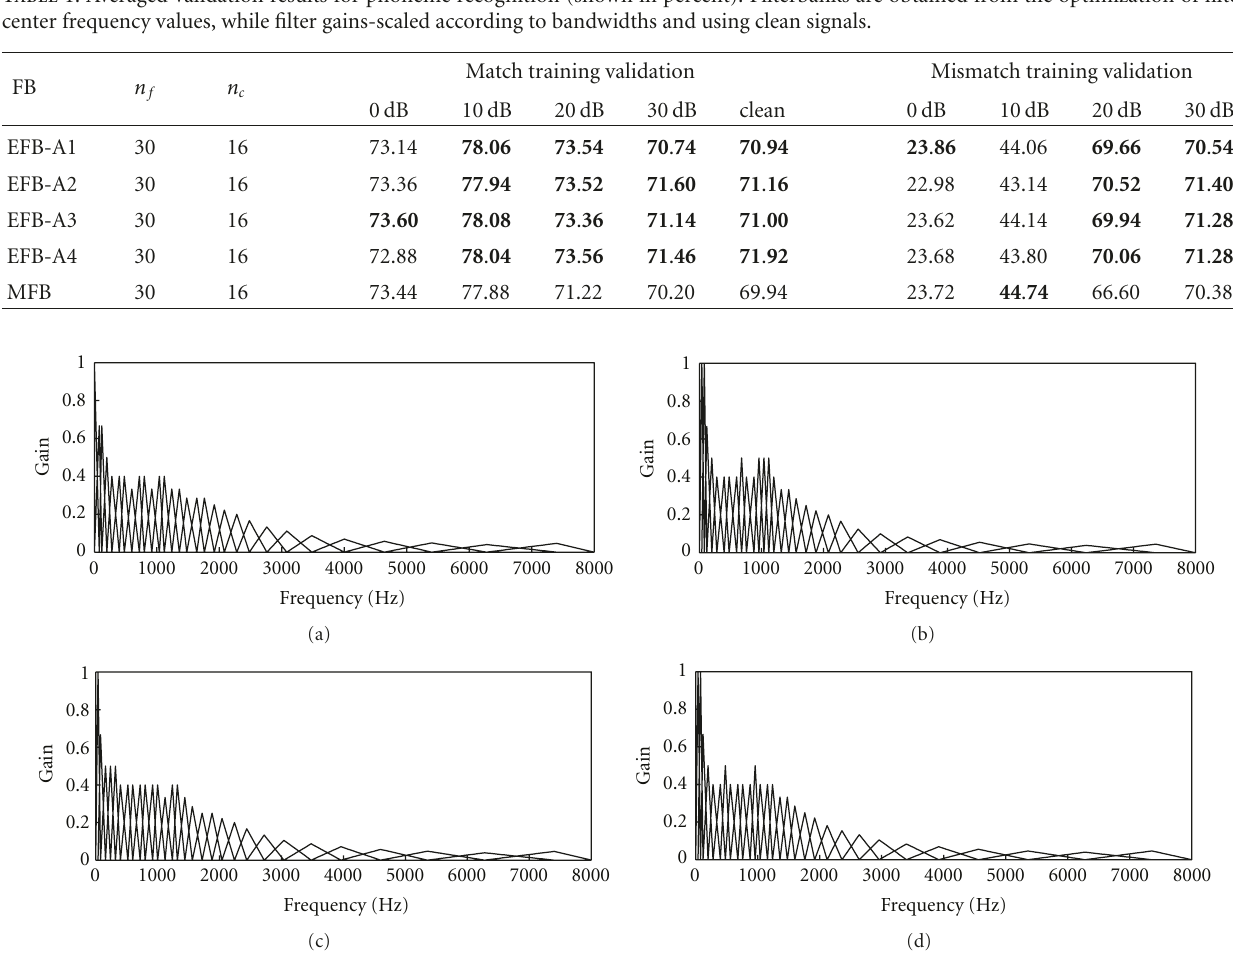
Figure 5: Evolved filterbanks obtained in the optimization of filter center positions only (filter gains normalized according to bandwidths) using clean signals. (a) EFB-A1, (b) EFB-A2, (c) EFB-A3 and (d)